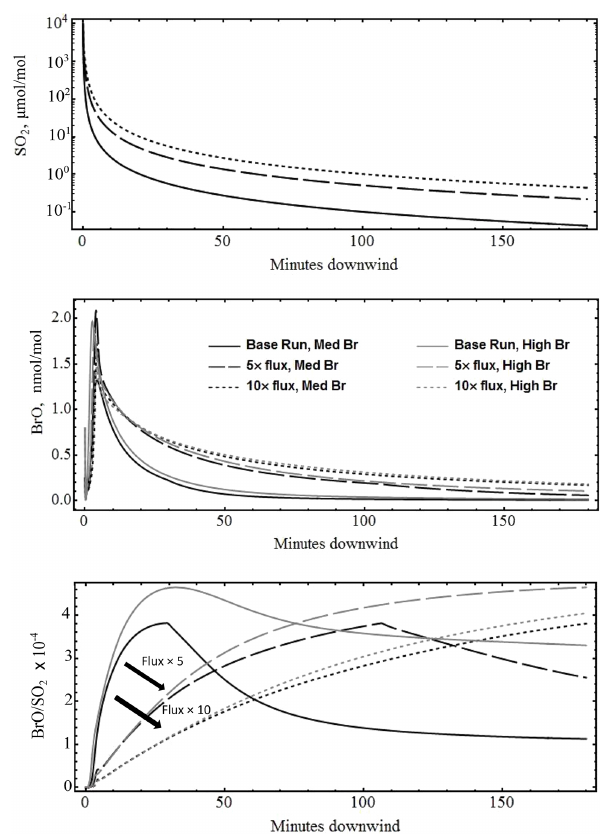
Figure 7. Simulated plume SO 2 , BrO and BrO/SO 2 over 3h for the medium- and high-bromine emission scenarios, and with varying volcanic emission flux (baseline run, and with volcanic gas + aerosol emissions flux × 5 and × 10, shown by full-, long-dashed and short- dashed lines, respectively), whilst keeping the same plume disper- sion parameterisation, wind speed and initialisation (see text for model details and interpretation). Arrows highlight the reduction in near-downwind BrO/SO 2 predicted at greater volcanic emission